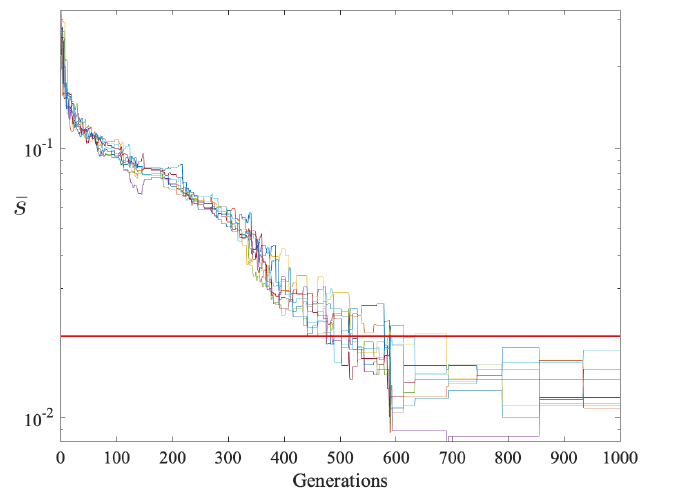
Figure 7. Row standard deviations versus generations for n = 20 players. There are 8 colored graphs, each one corresponding to a row in the demand matrix. All row deviations decreased to less than 0.02. The red line is at ¯ s =